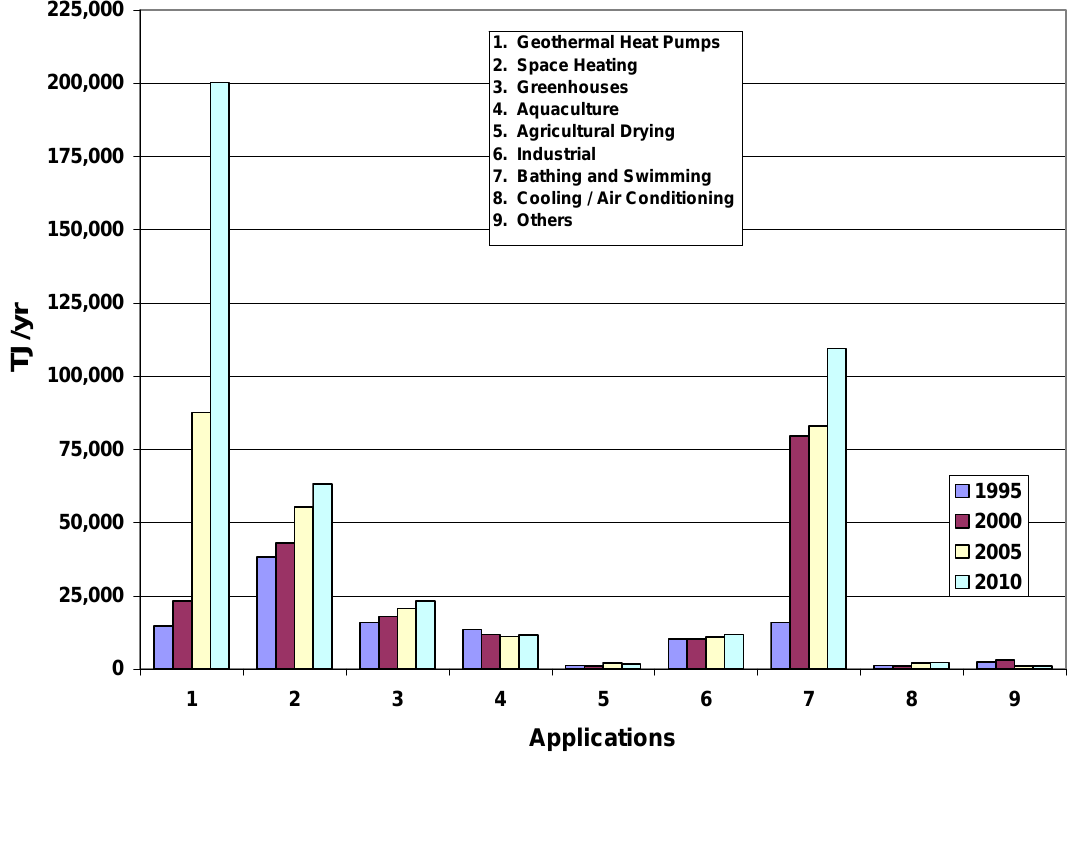
Figure 2. Comparison of worldwide energy in TJ/yr for 1995, 2000, 2005 and 2010